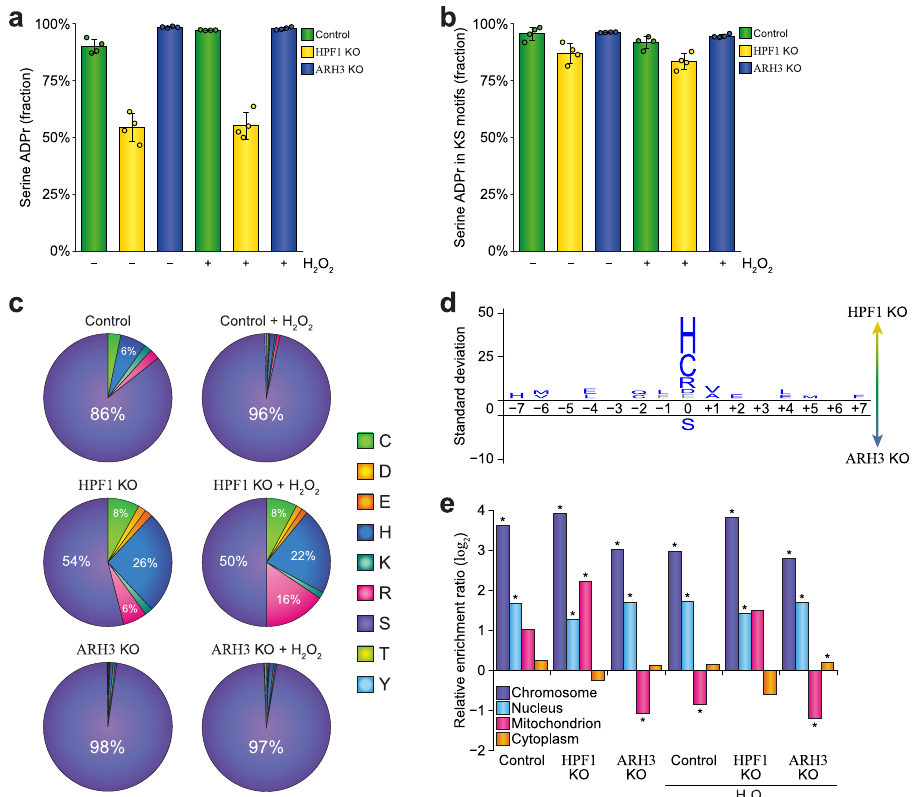
Fig. 5 Site-speci fi c properties of ADPr in HPF1 and ARH3 knockout cells. a Overview of the abundance fraction of ADPr modifying serine residues. n = 4 cell culture replicates, data are presented as mean values ± SD. b As a , but visualizing the fraction of serine ADPr in (lysine – serine) KS motifs. c Pie-chart analysis showing the distribution of ADPr sites across different amino acid residue types. d IceLogo analysis visualizes relative preference for ADPr to be targeted to different amino acid residue types. Amino acid residues displayed above the line were enriched for HPF1 KO, and those displayed below were enriched for ARH3 KO. Displayed amino acids were determined to be signi fi cantly changed at p < 0.05 as determined by two-tailed Student ’ s t testing using iceLogo software 77 , n = 50 and n = 1054 HPF1 KO and ARH3 KO ADP-ribosylation sites, respectively. p -Values for all amino acids were re-assessed using via two-tailed Fisher Exact testing with Benjamini – Hochberg correction, and are listed in the Source Data. Gray: not signi fi cantly different in the second statistical test. e Term enrichment analysis visualizing the Gene Ontology subcellular localization of ADPr target proteins across experimental conditions. n = 99 (control), n = 35 (HPF1 KO), n = 575 (ARH3 KO), n = 429 (control + H 2 O 2 ), n = 45 (HPF1 KO + H 2 O 2 ), n = 756 (ARH3 KO + H 2 O 2 ) ADPr target proteins, tested versus a background of n = 21,297 proteins, with Gene Ontology subcellular localization annotated for n = 402 chromosomal, n = 5298 nuclear, n = 1166 mitochondrial, and n = 5027 cytoplasmic proteins. Signi fi cance was determined via two-tailed Fisher Exact testing with Benjamini – Hochberg correction for multiple hypotheses testing, * p < 0.05. Individual p -values are listed in the Source Data. Source data are provided as a Source Data fi